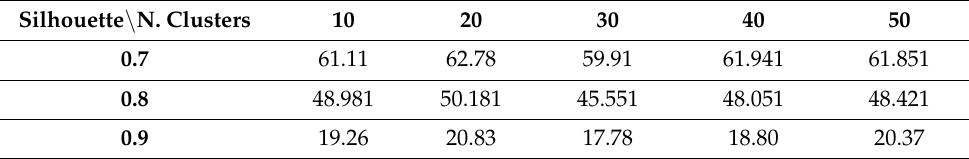
Table 60. Clustering performance in terms of silhouettes using the reduced dataset with SPQR applied to normalized data. Silhouette \ N.